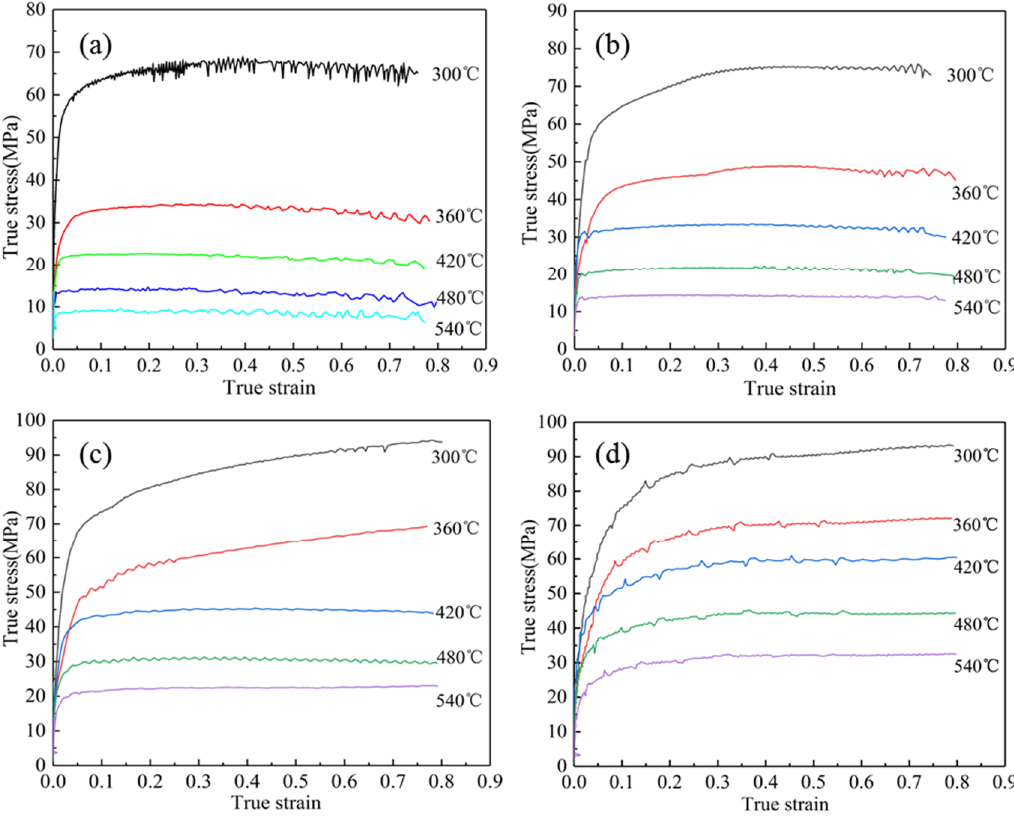
Figure 2. True stress–true strain curves of the composite modified 6063 aluminum alloy during hot compression: ( a ) (cid:2013)̇ = 0.01 s −1 ; ( b ) (cid:2013)̇ = 0.1 s −1 ; ( c ) (cid:2013)̇ = 1 s −1 ; ( d ) (cid:2013)̇ = 10 s −1 .